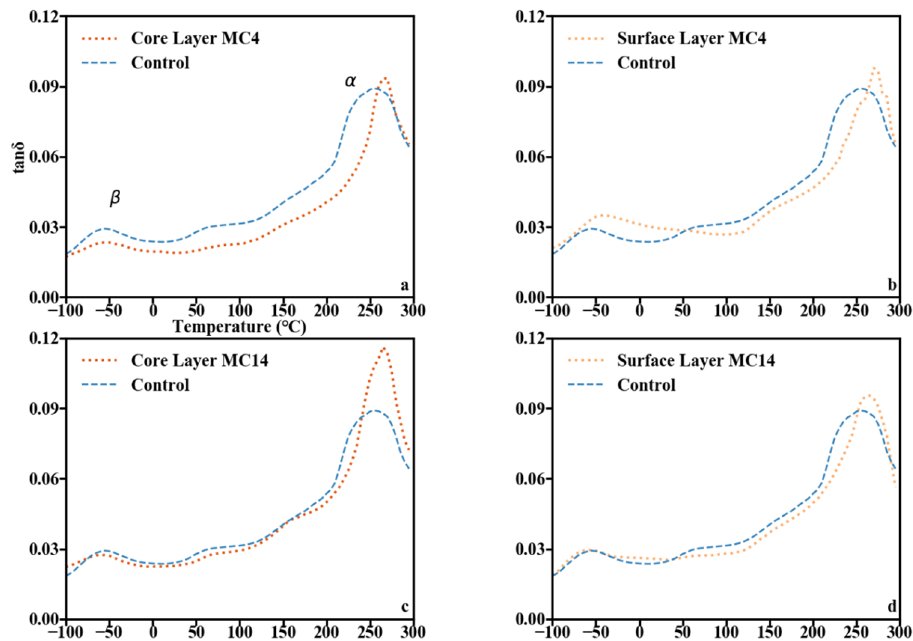
Figure 8. Comparison of loss tangent over temperature between the control sample and: ( a ) core layer of sample MC4; ( b ) surface layer of sample MC4; ( c ) core layer of sample MC14; ( d ) surface layer of sample MC14.